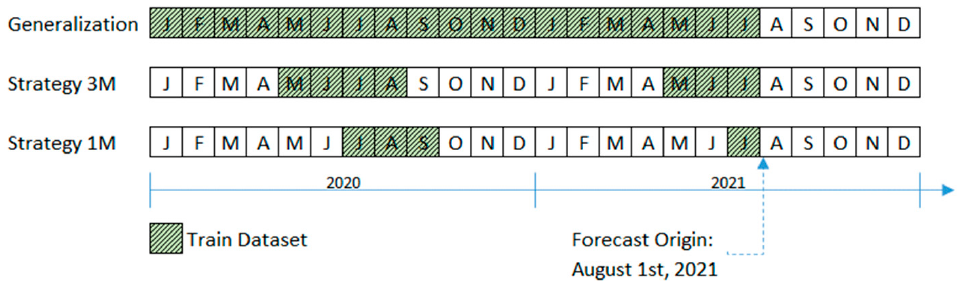
Figure 2. The proposed training